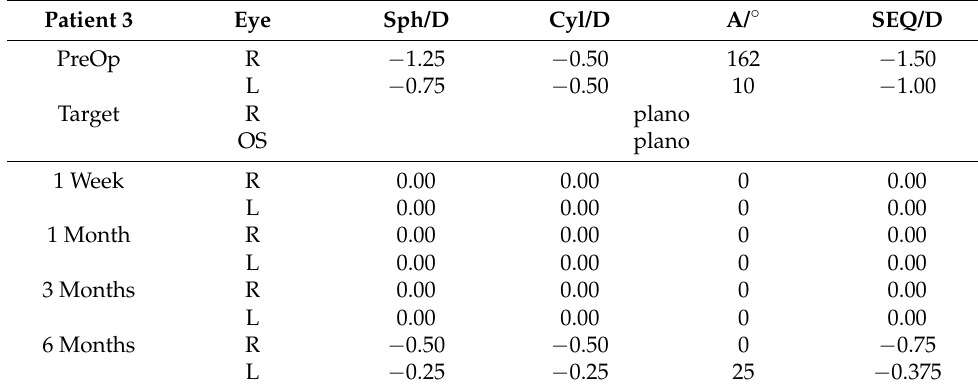
Figure 6. Visual outcomes of patient No. 3. Table 5. Summary of visual outcomes of patient